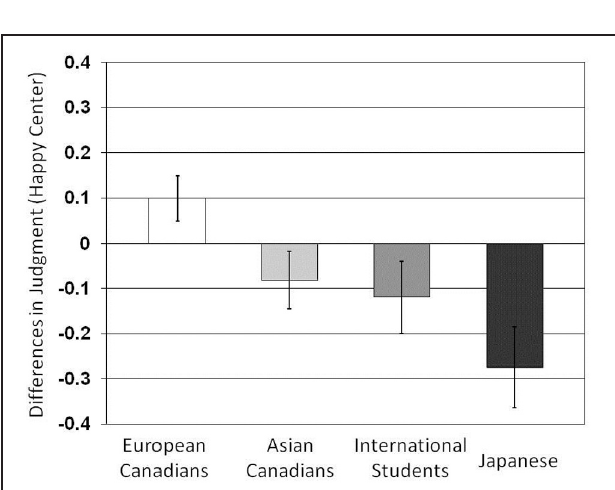
FIGURE 3 | Comparison of affective context scores for the four cultural